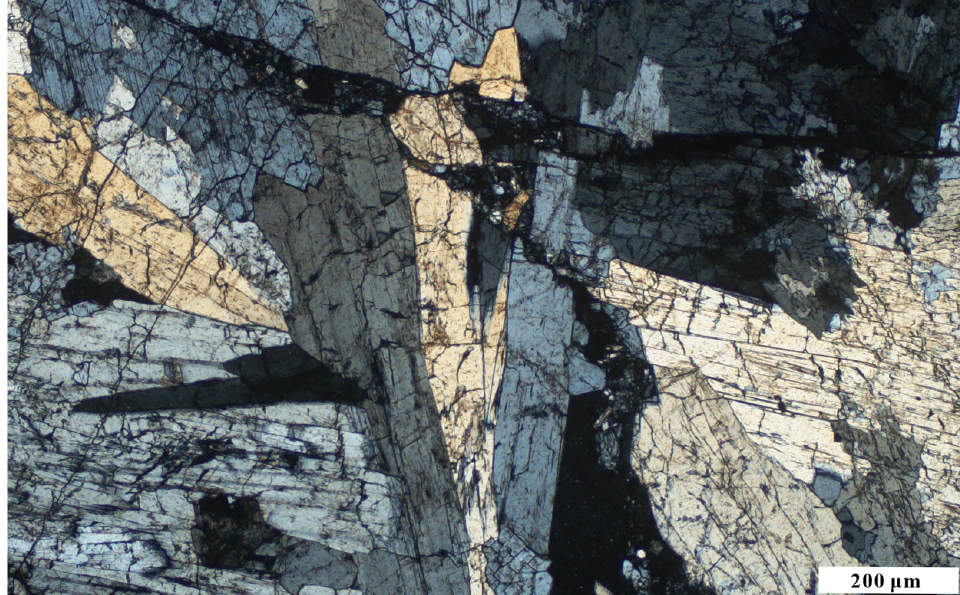
Figure 4. The jadeite grains display euhedral to subhedral prismatic crystal habits (under cross- polarized light).